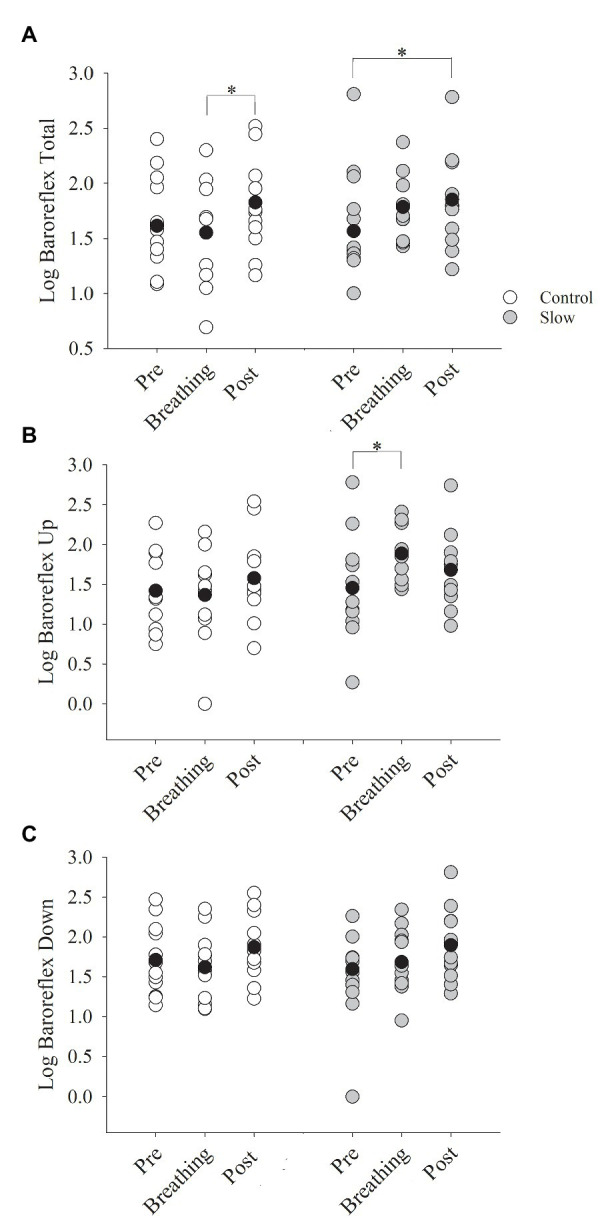
Baroreflex sensitivity (BRS) before, during, and after both breathing conditions. (A) BRS total increased from during breathing to post-test only for the control breathing condition (p = 0.01). (B) BRSup increased from pre-test to during breathing for the slow breathing condition only (p < 0.01). (C) BRSdown did not change for either slow or control breathing condition (p = 0.10). BRSup, up baroreflex sensitivity; BRSdown, down baroreflex sensitivity. Black circle indicates average data, *significant difference.